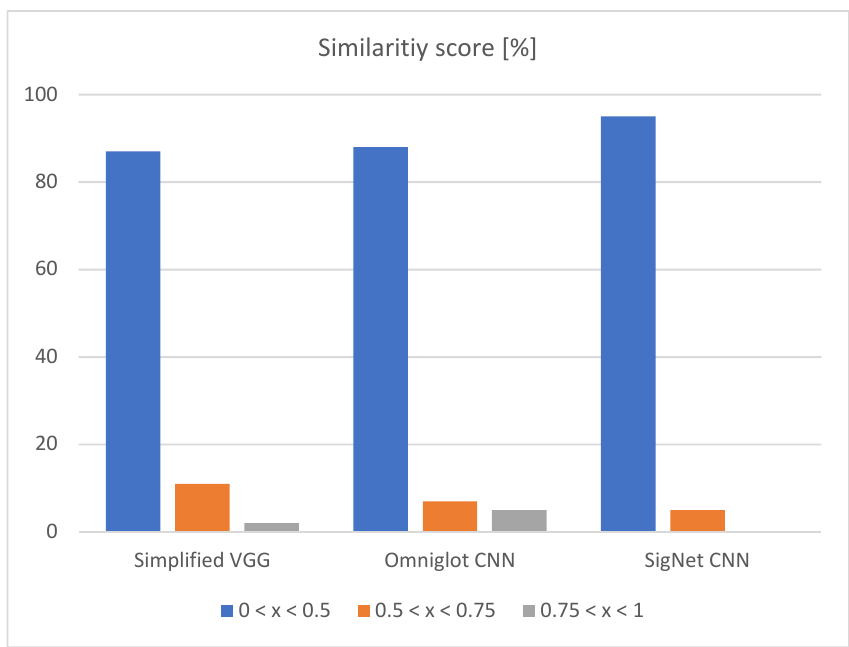
Figure 5. Input vs. random train image from each class—similarity score.